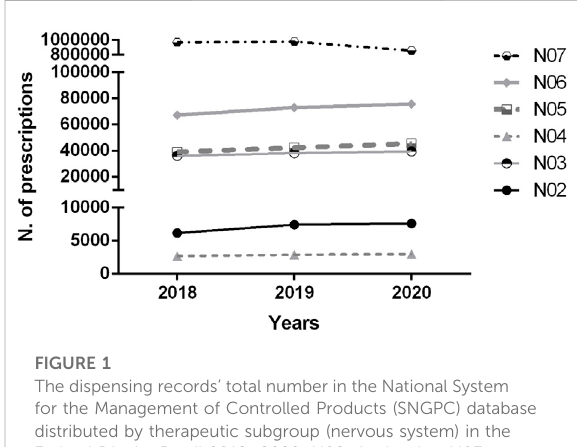
consumption measured in adjusted DHD and, on the horizontal (X) axis, the time measured in calendar months; therefore, the accumulated DHD in the month is measured. Figures 2B – F display the same series as Figure 2 individually to highlight R 2 and con fi dence interval (shaded CI) data pertinent to each